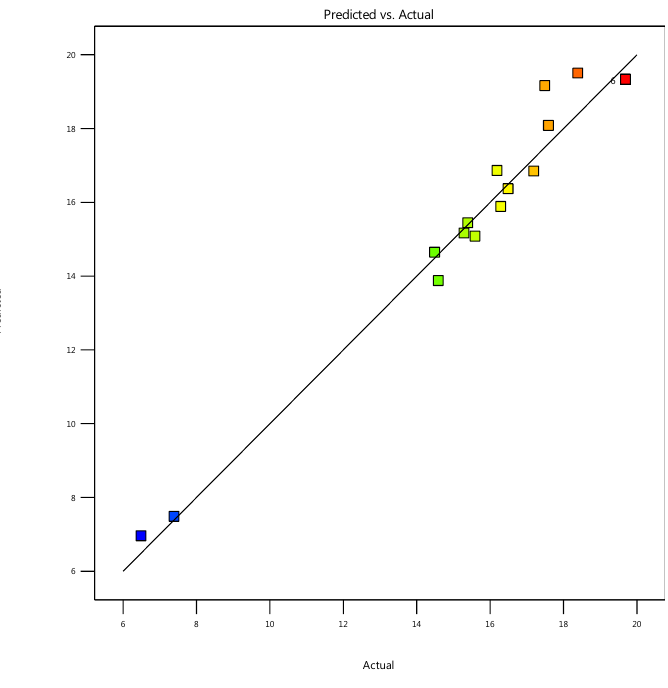
Figure 2. Predicted versus actual viscosity of OBMB